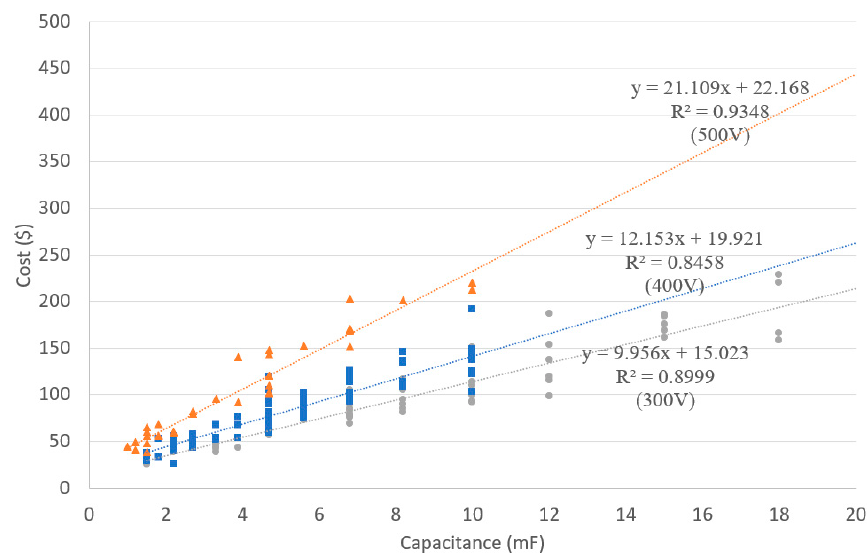
Figure 18. Cost model of electrolytic capacitor.